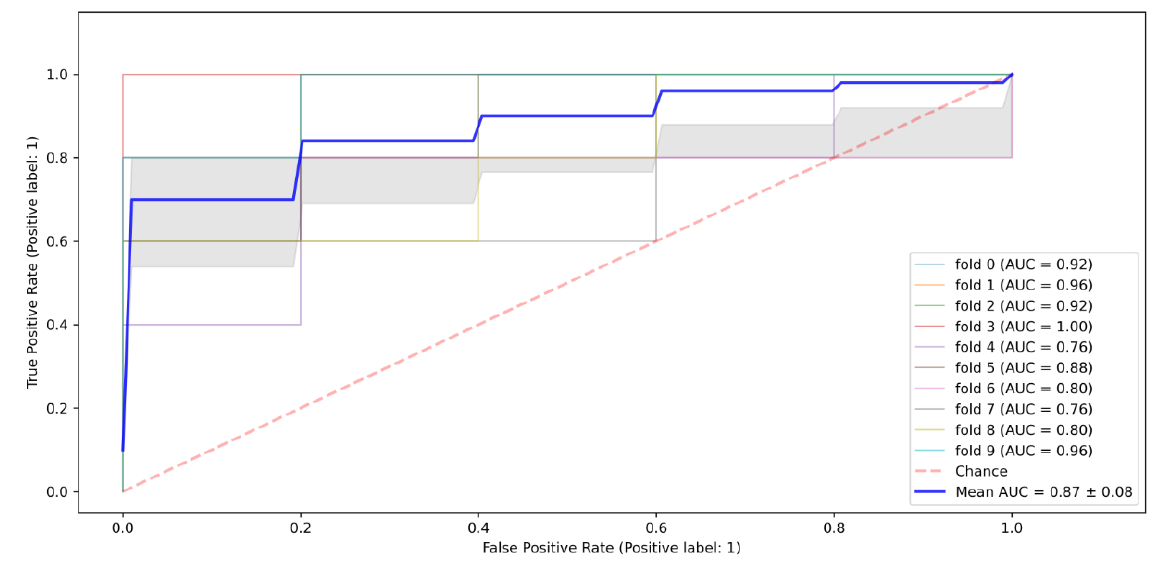
Figure 4. Naïve Bayes ROC algorithm ROC Curve.